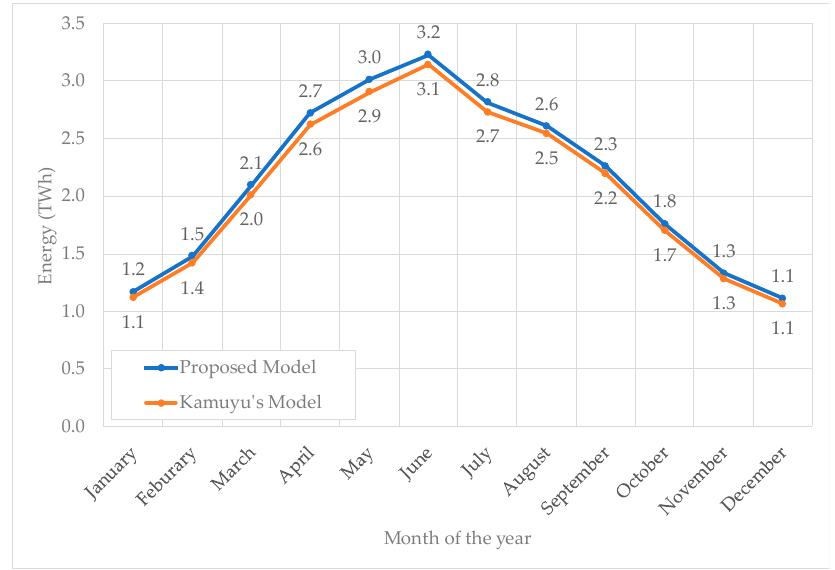
Figure 8. Monthly energy yield of a simulated foam-based FPV system installed on 10% of Lake Mead’s surface using historical data from 2018. Comparison between the proposed model (c-Si flexible foam-backed FPV) and a tilted FPV based on Kamuyu’s model (c-Si aluminum mount FPV).